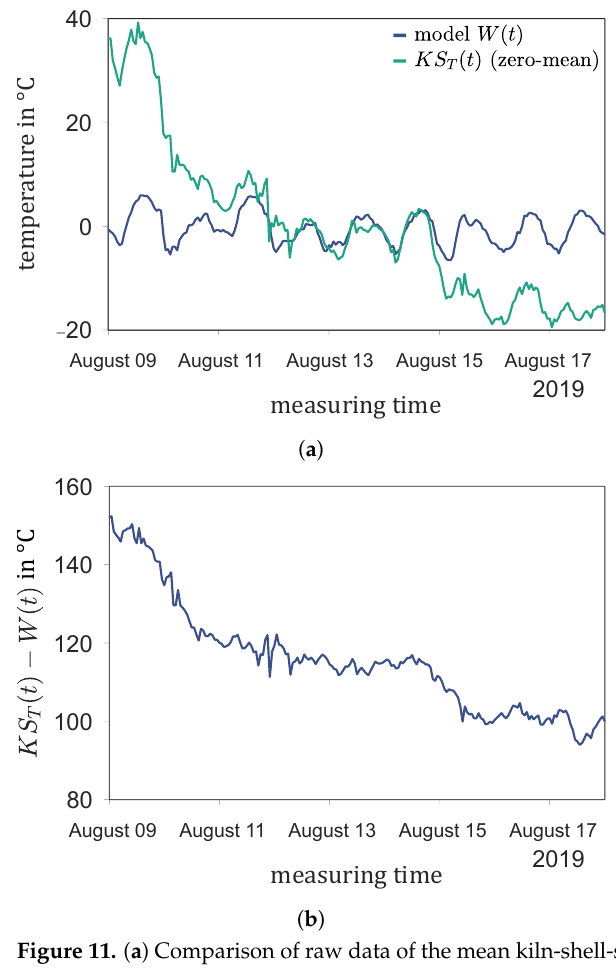
Figure 11. ( a ) Comparison of raw data of the mean kiln-shell-scanner temperature and the associated weather model; ( b ) weather-compensated mean kiln-shell-scanner temperature. An analysis of kiln-shell temperature according to Section 4.2 is executed for the melting process in February 2020 (Figure 6) and for another one on the same kiln in March 2020 (Figure 12).